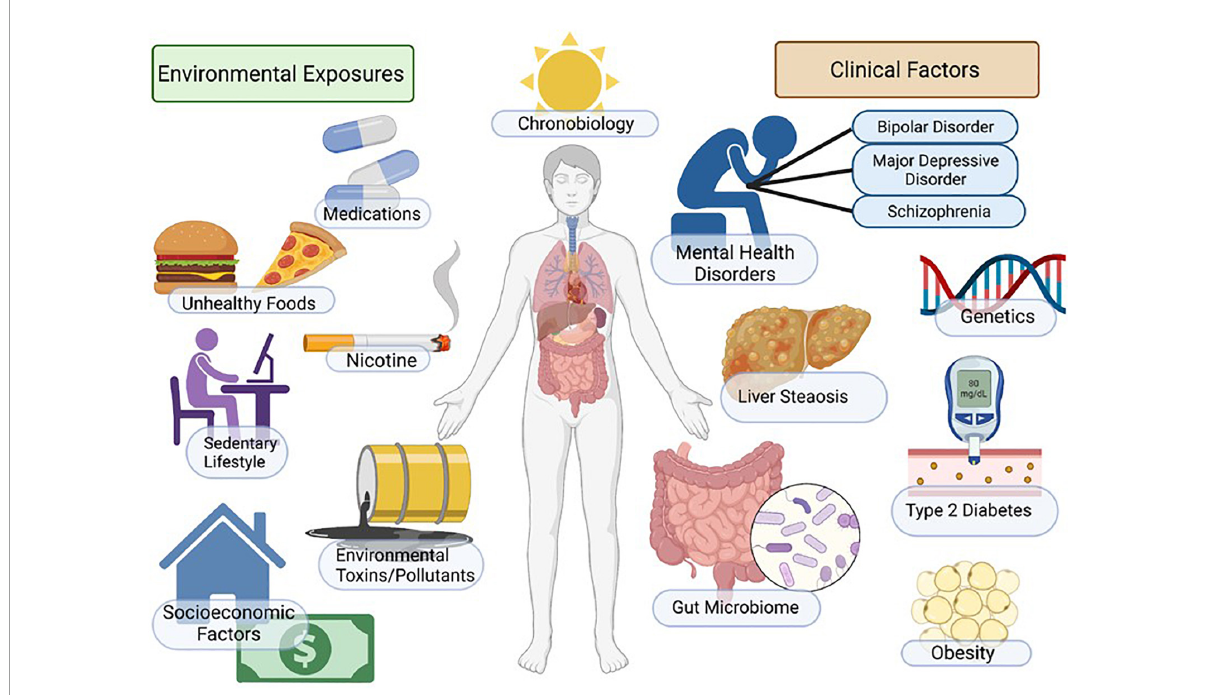
FIGURE1 Factors regulating mood, metabolism, and NAFLD. Incidence of NAFLD in patients with mental illness is high and myriad factors contribute to increased disease risk. Patients with depression and mood disorders are more likely to be impacted by socio-economic stress, housing insecurity, poor access to healthcare, poor diet, smoking/nicotine consumption, sedentary lifestyle and sleep/circadian disruption. Additional environmental factors include genetic factors, exposure to environmental toxins and increased metabolic risk associated with psychotropic medications. Outcomes include increased adiposity, insulin resistance/diabetes, NAFLD/NASH and increased cardiovascular disease risk. Figure created with